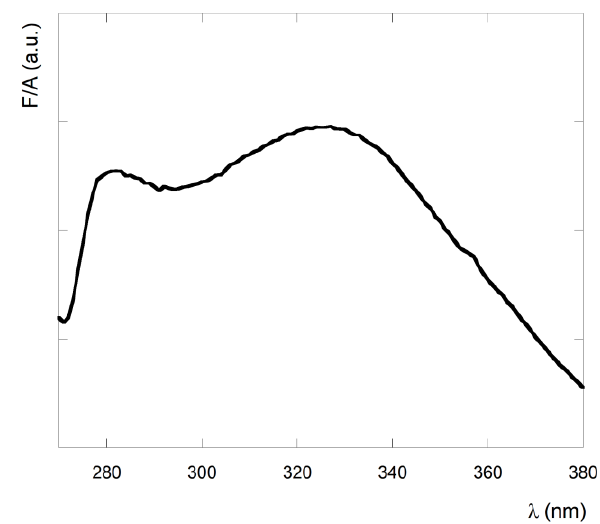
Figure 5. Fluorescence spectrum of peptide 1 fibrillar nanostructures in CH 2 Cl 2 solution at a concen- tration of 2.8 × 10 − 3 M. According to Ref. [61] the fluorescence emission spectrum of the filaments was obtained by exciting the sample at λ ex = 315 nm. Continuous line: fresh solution, dotted line: solution after ten days.